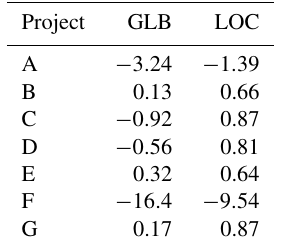
Table 7. Monthly NSE of the irrigation